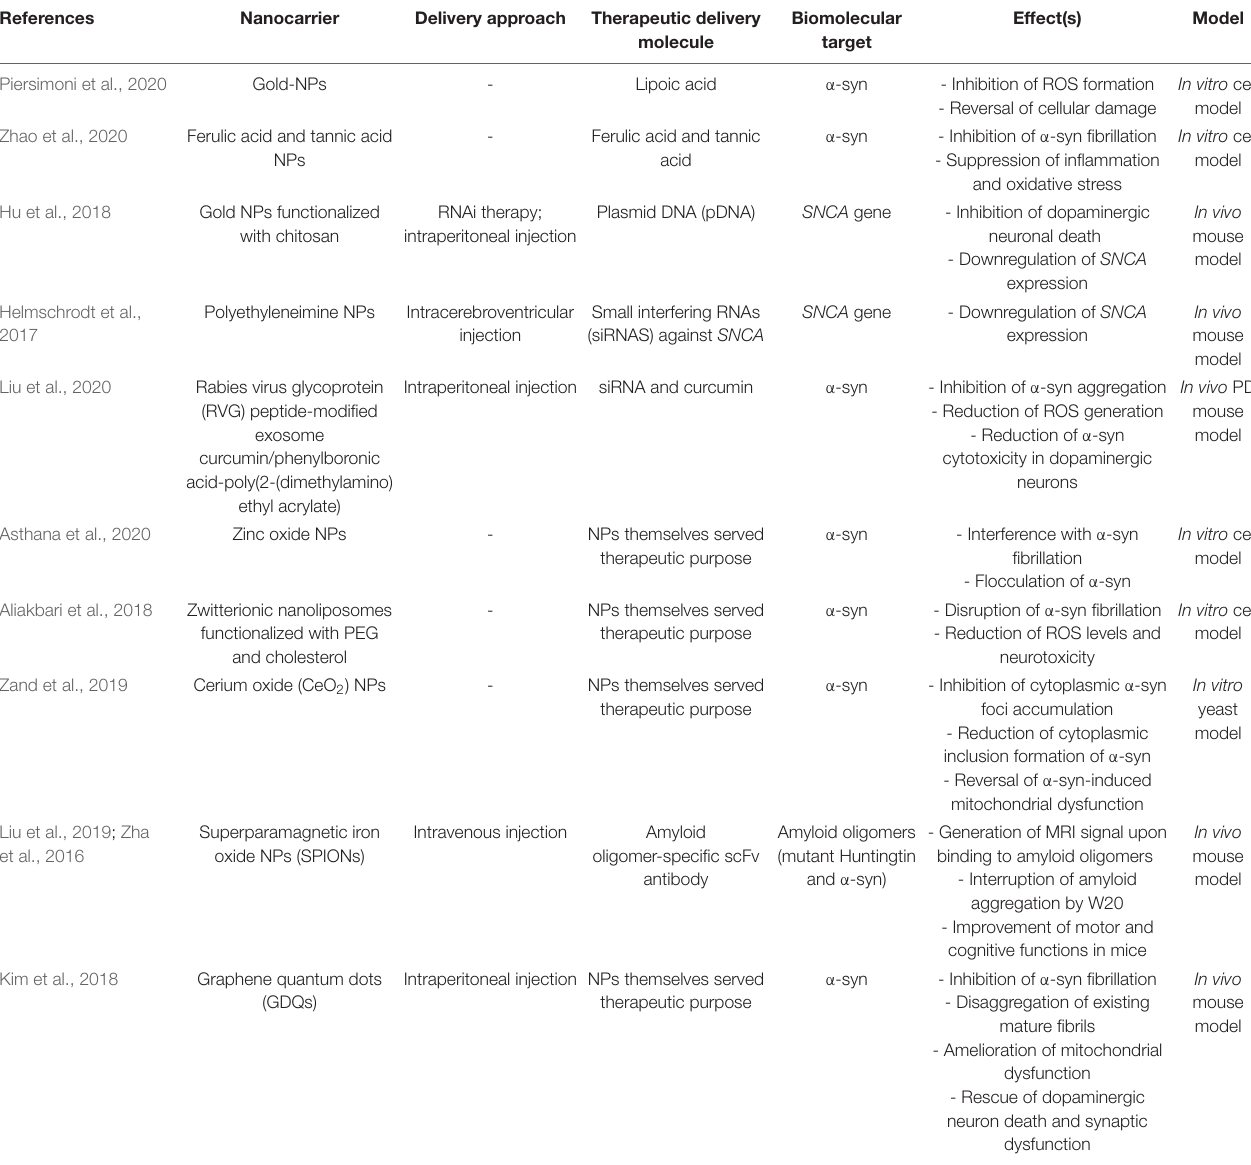
TABLE 1 | List of common nanocarriers used to transport therapeutic agents to biological targets implicated in